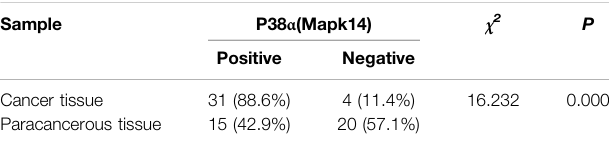
TABLE 2 | Immunohistochemical detection of Mapk14 protein expression in CRC and paraneoplastic tissues.